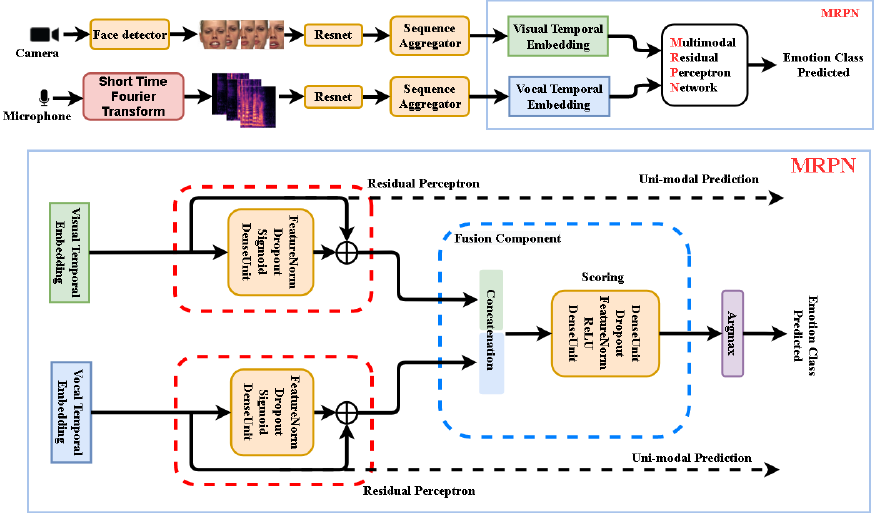
Figure 1. The proposed multi-modal emotion recognition system using Deep Neural Network (DNN) approach. Upper part: Video frames and audio spectral segments get independent temporal embeddings to be fused by our multi-modal Residual Perceptron Network (MRPN). Lower part: MRPN performs in each modality normalizations via the proposed residual perceptrons and then scores their concatenated outputs in the fusion component. The uni-modal prediction branches are only active in training mode.